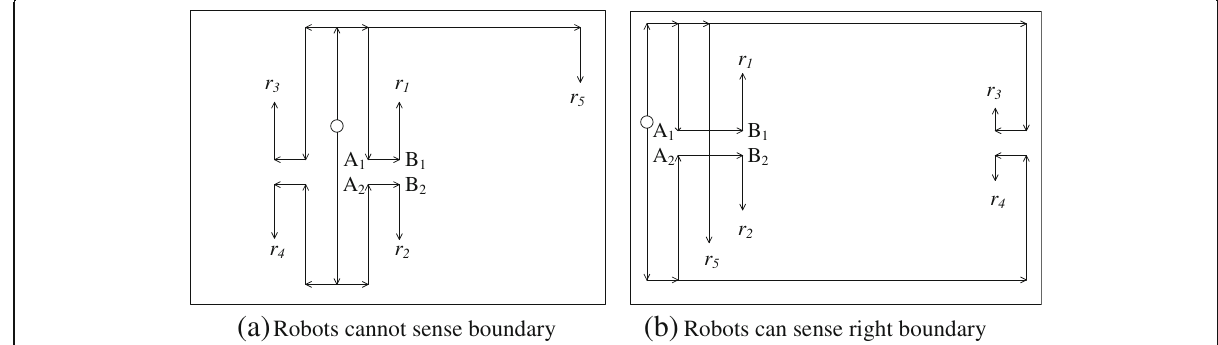
Fig. 1 Initialization for exploration discourse of a multi-robot system ( n =5); in the figure, r i represents robot i ( i =1, … , 5), A j and B j represent rendezvous start and end locations of r j ( j =1, 2), respectively, and all arrows represent moving directions of the corresponding